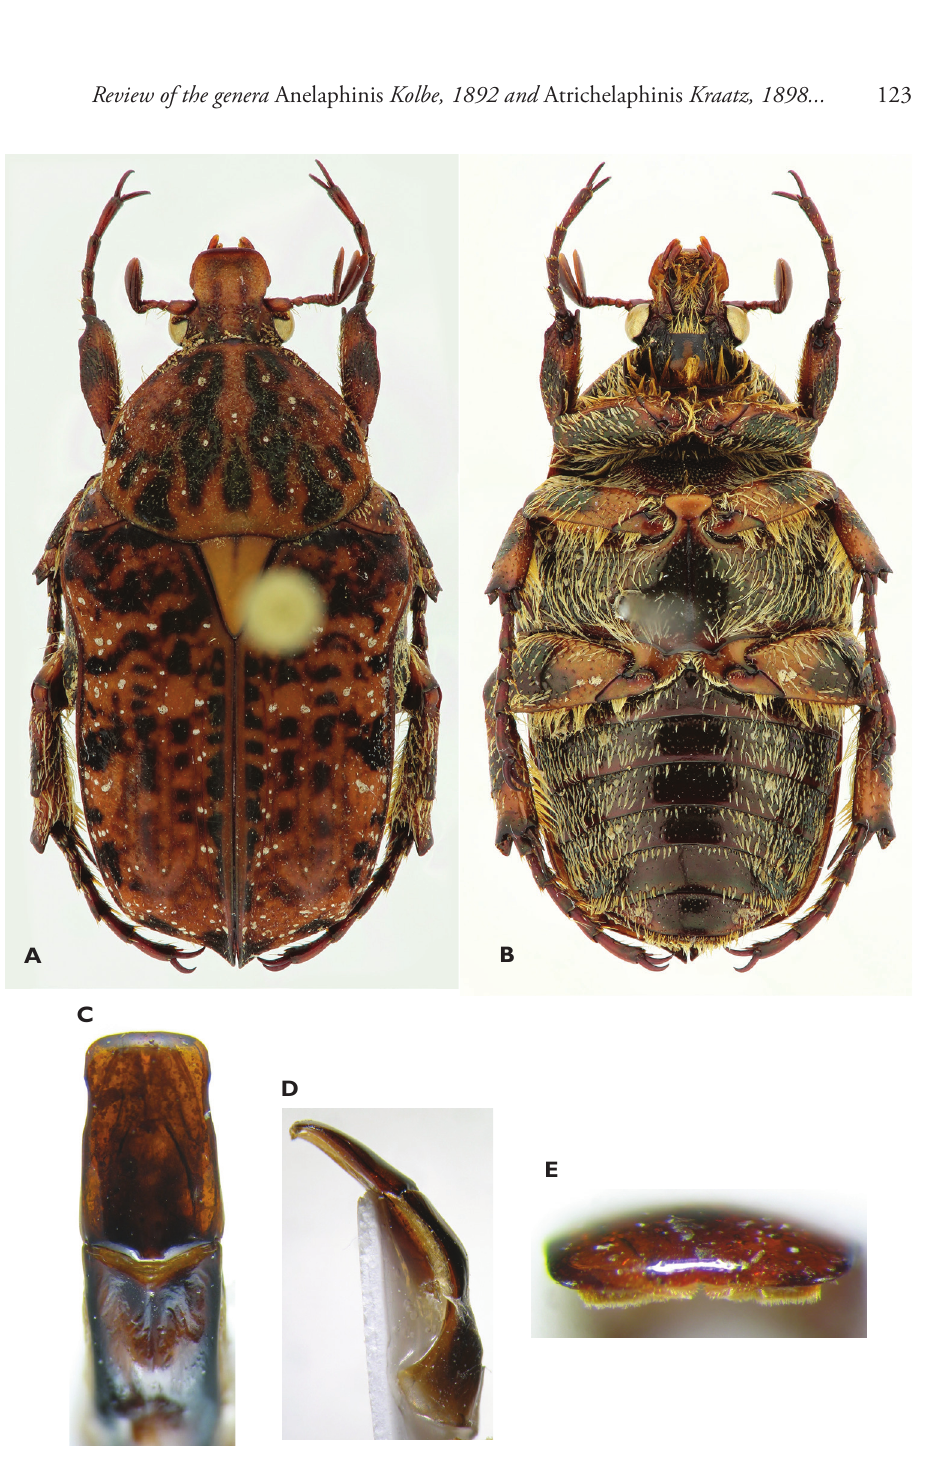
Figure 13. Atrichelaphinis ( Eugeaphinis ) garnieri sp. n., holotype male (PCSR). A Dorsal view B ventral view C parameres in dorsal view D parameres in lateral view E apex of parameres.